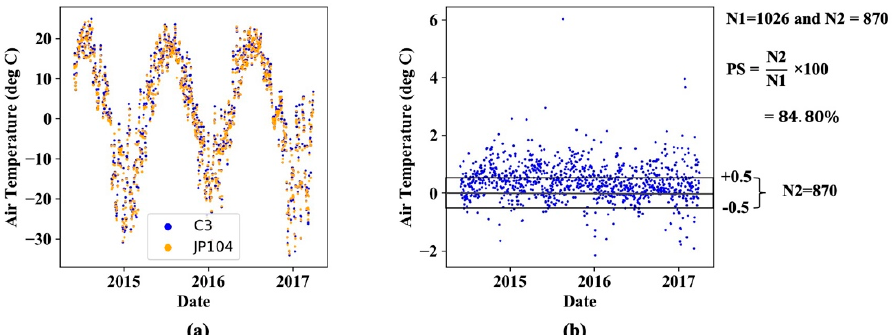
Figure 2. Example calculation of percentage of similarity (PS) for the parameter of air temperature (AT) for station-pair C3 vs. JP104 in Group 3 along with their time-series ( a ), and differences ( b ).